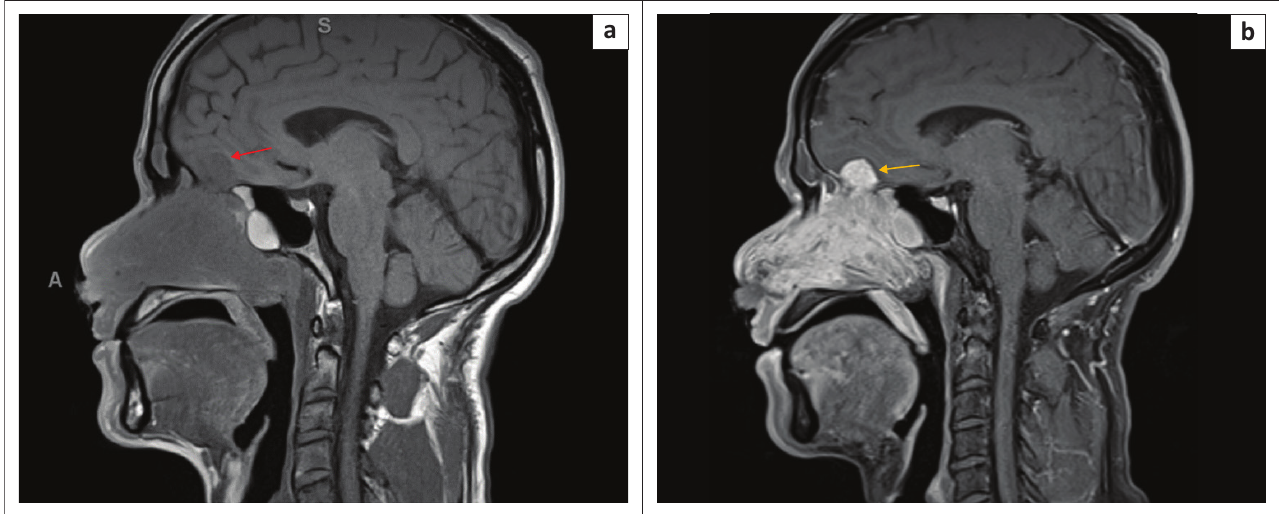
FIGURE 3: (a) T1 turbo spin echo (TSE) sagittal MR image shows a homogeneously mass, iso-intense to grey matter and muscle (red arrow). (b) Sagittal T1 turbo spin echo (TSE) with fat saturation (FS) with gadolinium-enhanced MR image shows a diffusely heterogeneous enhancing tumour in the left nasal cavity that transgresses the cribriform plate extending intracranially (orange